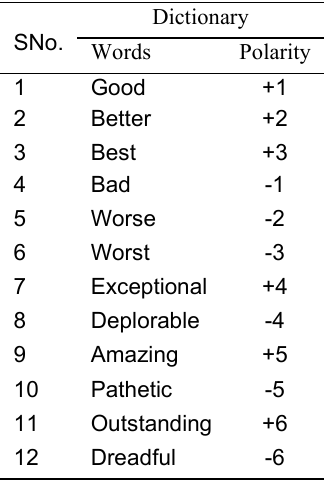
Table 1. A sample dictionary words along with polarity .